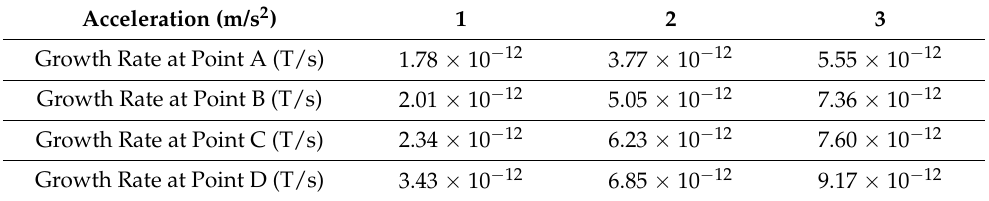
Table 4. The growth rate of the wake magnetic field under different accelerations. Acceleration (m/s 2 ) 1 Growth Rate at Point A (T/s) Growth Rate at Point B (T/s) Growth Rate at Point C (T/s) Growth Rate at Point D